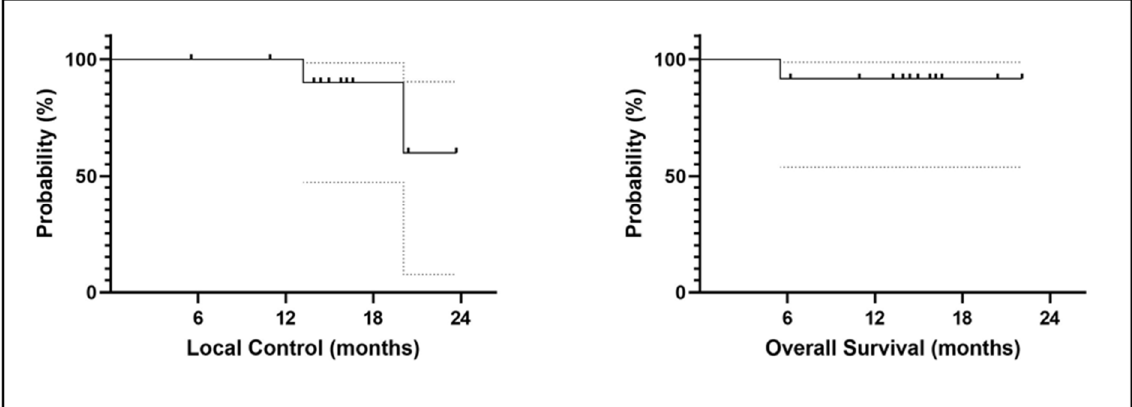
Figure 4. Local control ( left ) and overall survival ( right ) curves .